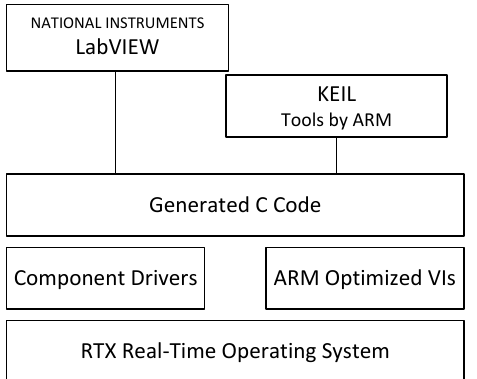
Figure 15. Software architecture of ARM programming by LabVIEW.